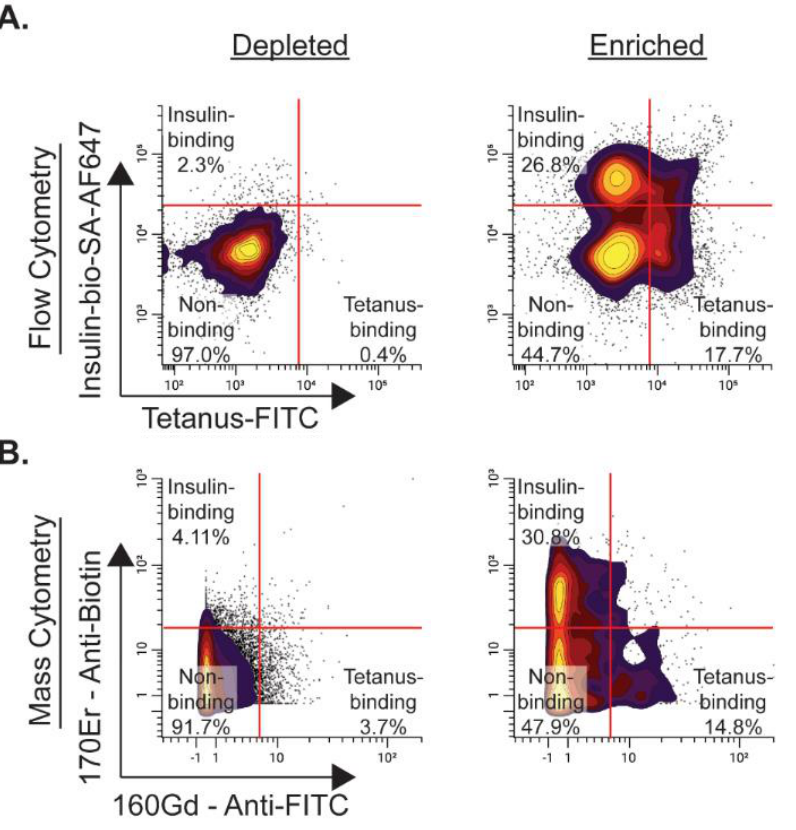
Figure 2. Representative comparison of enrichment of insulin and tetanus-binding B cells using flow cytometry and mass cytometry shows similar binding cell frequencies. Approximately 60 million PBMCs were collected from a single human donor, split in half, with each half enriched for insulin and tetanus-binding B cells as described in this protocol. ( A ) Representative binding of insulin and tetanus- binding B cells of depleted and enriched fractions using flow cytometry. ( B ) Representative binding of insulin and tetanus-binding B cells using mass cytometry. For the flow cytometry sample, the addition of fluorescently labeled antibodies (BV421 anti-CD19 and PerCP anti-CD3) and Streptavidin- AlexaFluor647 to detect biotinylated insulin bound to the BCR were incubated with the cells in place of metal-labeled antibodies and secondaries. Depleted fractions are negatively enriched cells and enriched fractions are positively enriched cells. Data were analyzed using